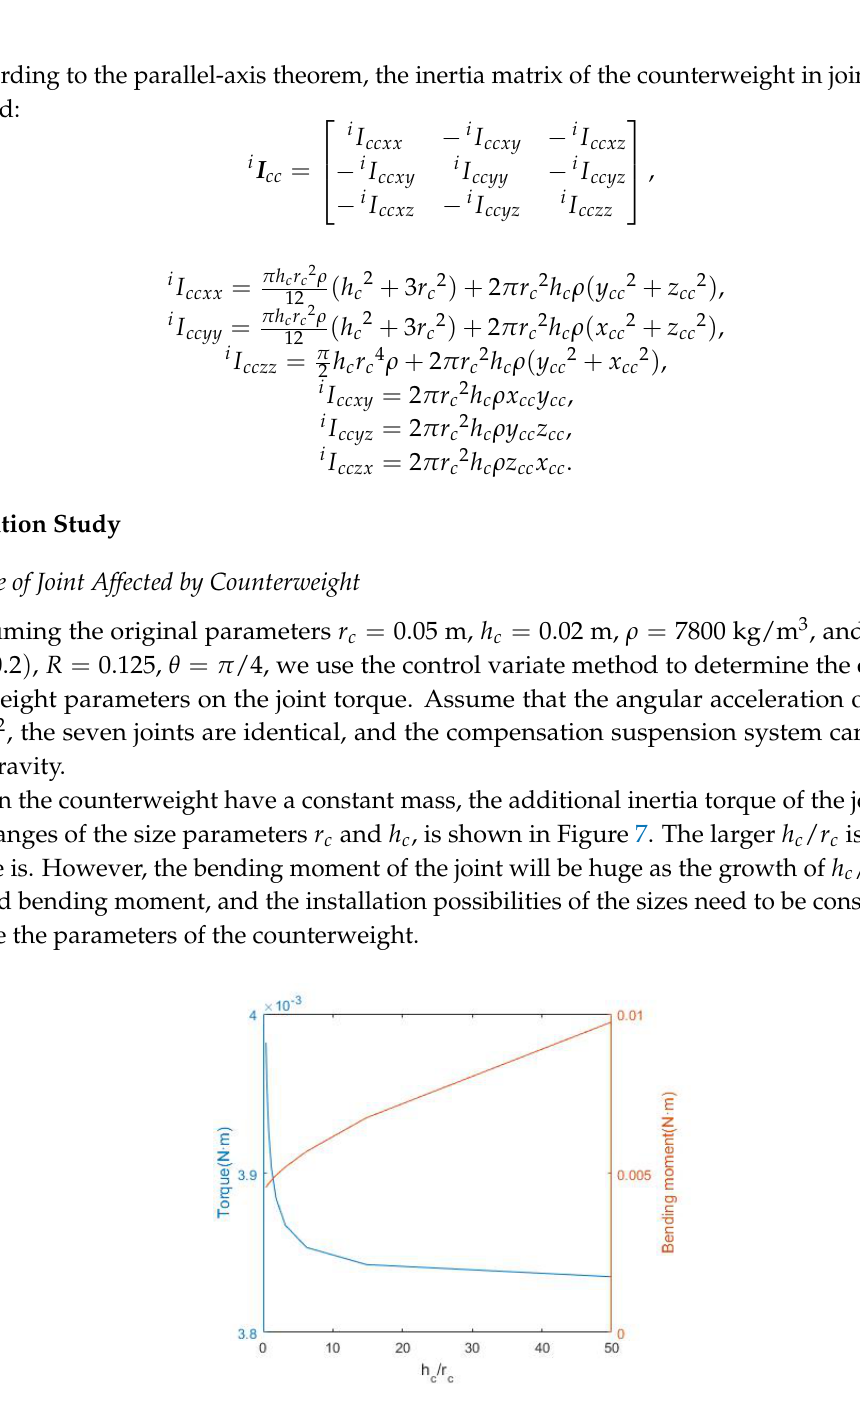
Figure 7. Joint torque and bending moment affected by r c and h c